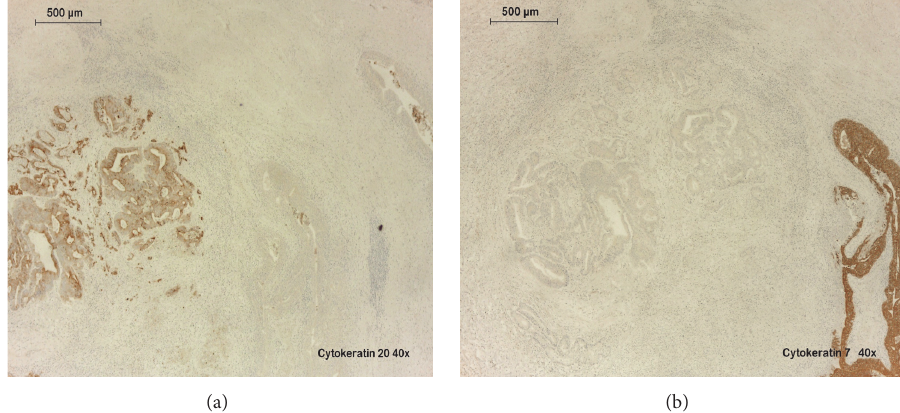
Figure 4: Immunostains: (a) CK20 positive staining in the tumor and negative staining in the overlying urothelium; (b) CK7 negative staining in the tumor and positive staining in the